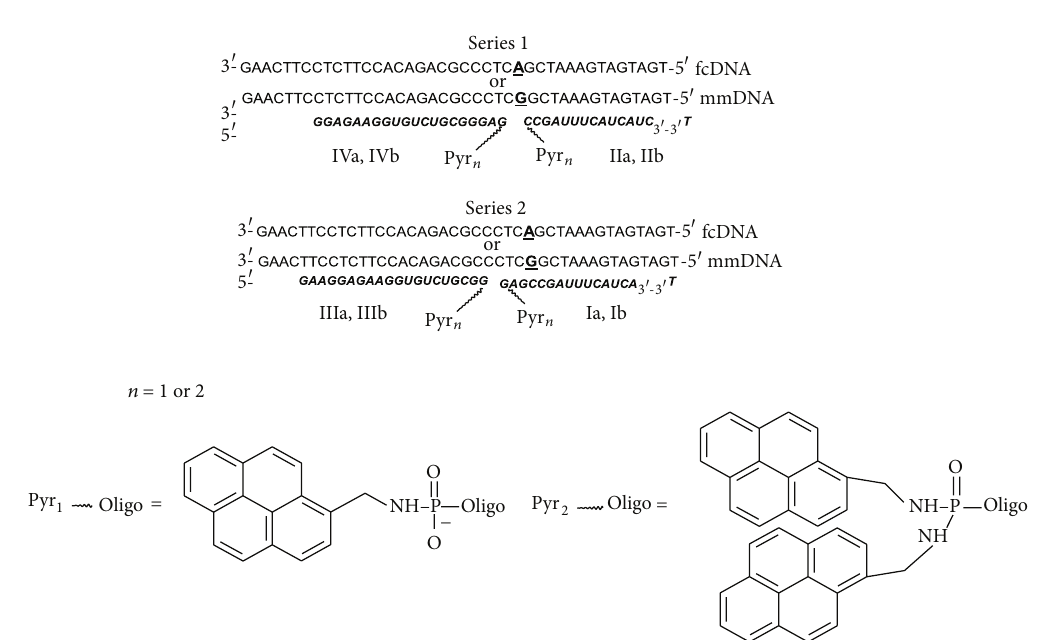
Figure 2: Duplexes of tandem probes and DNA targets. N-deoxyribonucleotide, N = 2 󸀠 -O-methylribonucleotide. mmDNA = DNA target with mononucleotide substitution; fcDNA = fully complementary DNA target. IVa, IVb, IIIa, IIIb = 3 󸀠 -components, IIa, IIb, Ia, Ib = 5 󸀠 -